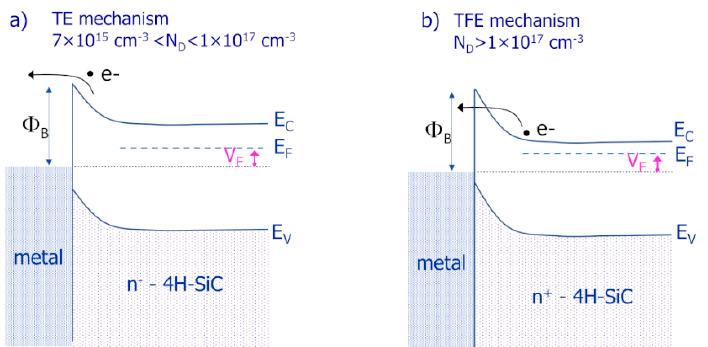
Figure 2. Schematic energy band diagrams for the metal/4H-SiC contact under forward bias V F , according to the predominance of the ( a ) thermionic emission (TE) or ( b ) thermionic field emission ( TFE ) current transport mechanism. Table 1. Schottky barrier height for metal/n-type 4H-SiC system for different metals. The values were determined by I–V measurements on Schottky